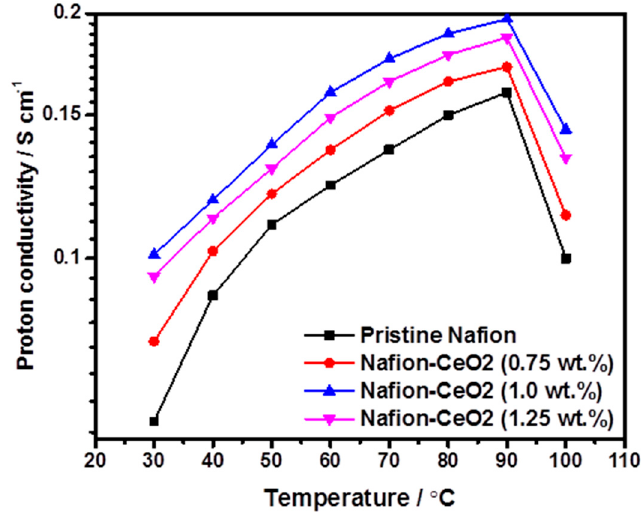
Figure 5. Proton conductivity of pristine Nafion and Nafion-CeO 2 composite membranes at different temperatures under 100% RH. temperatures under 100% RH.